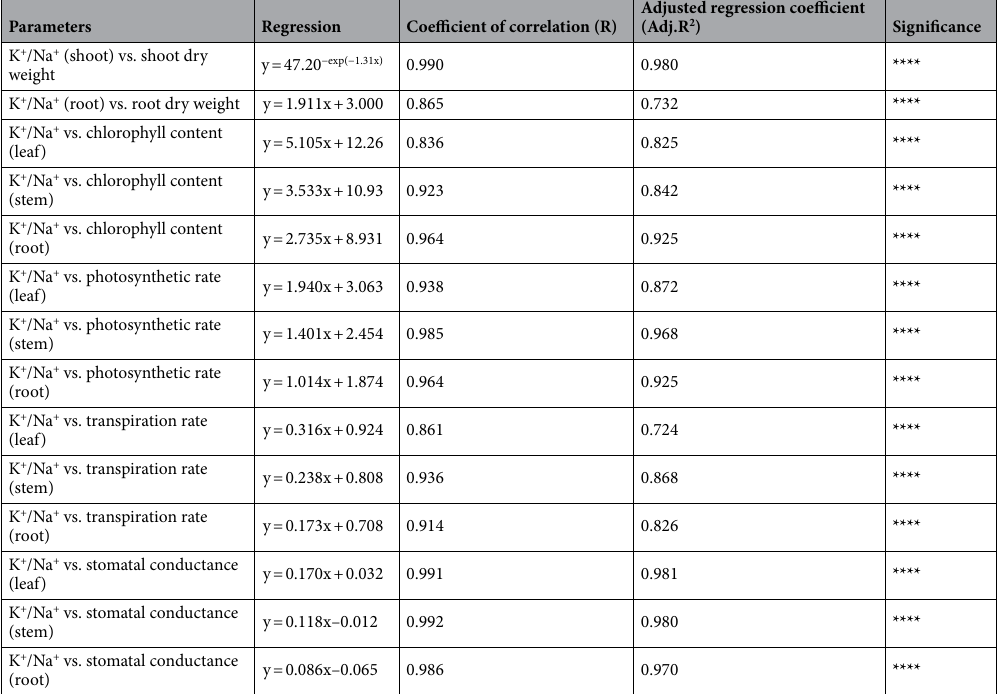
Table 2. Regression between ionic contents (Na + and K + ) in shoot and root of guava plant ( Psidium Guajava L.), and stress tolerance against salinity and water stress treatments. Na + and K + denote sodium and potassium, respectively. Results are significant at p ≤ 0.0001 represented by ****y. All regressions are based on first order kinetics equation (y = bx + a) where “a” is the intercept, and “b” is the slope value for the regression except regression between K + /Na + (shoot) and shoot dry weight is based on exponential model (y = a −exp(bx)